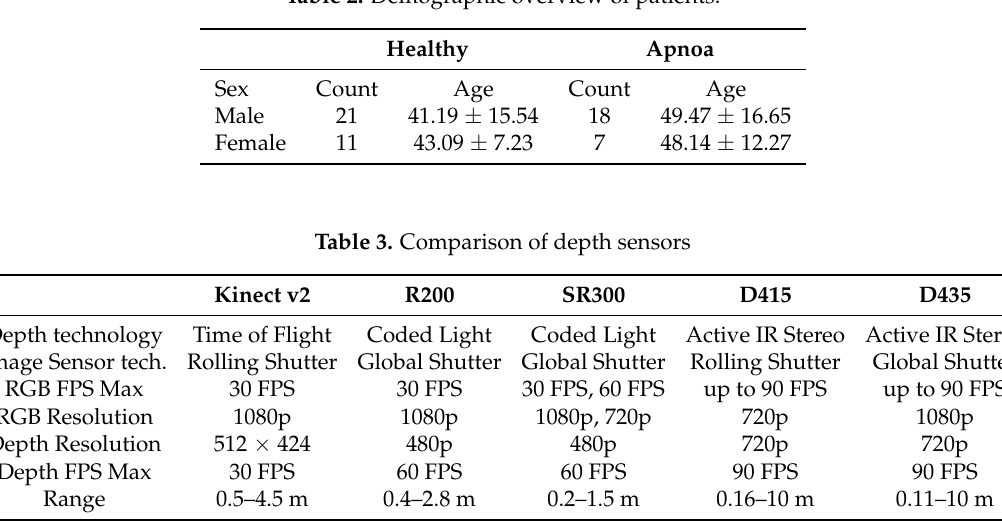
Table 2. Demographic overview of patients.